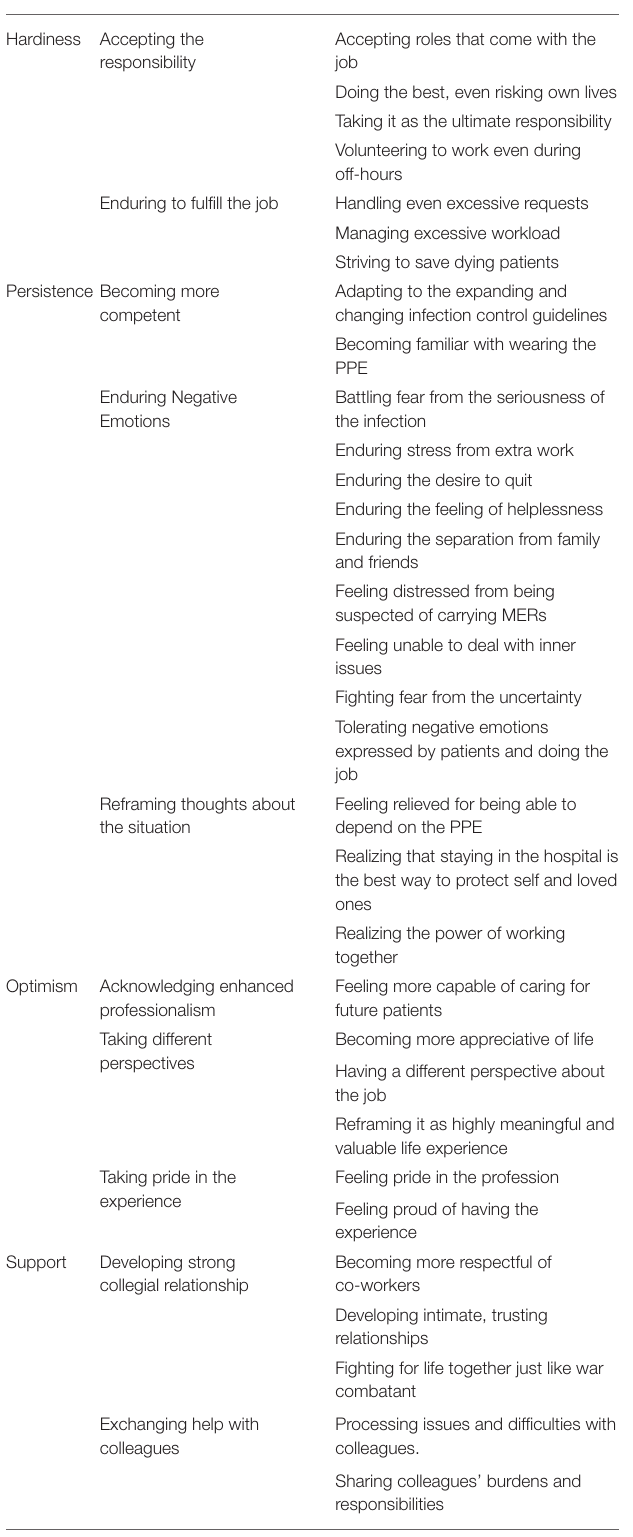
TABLE 8 | Sub-themes and codes from the qualitative analysis. Theme